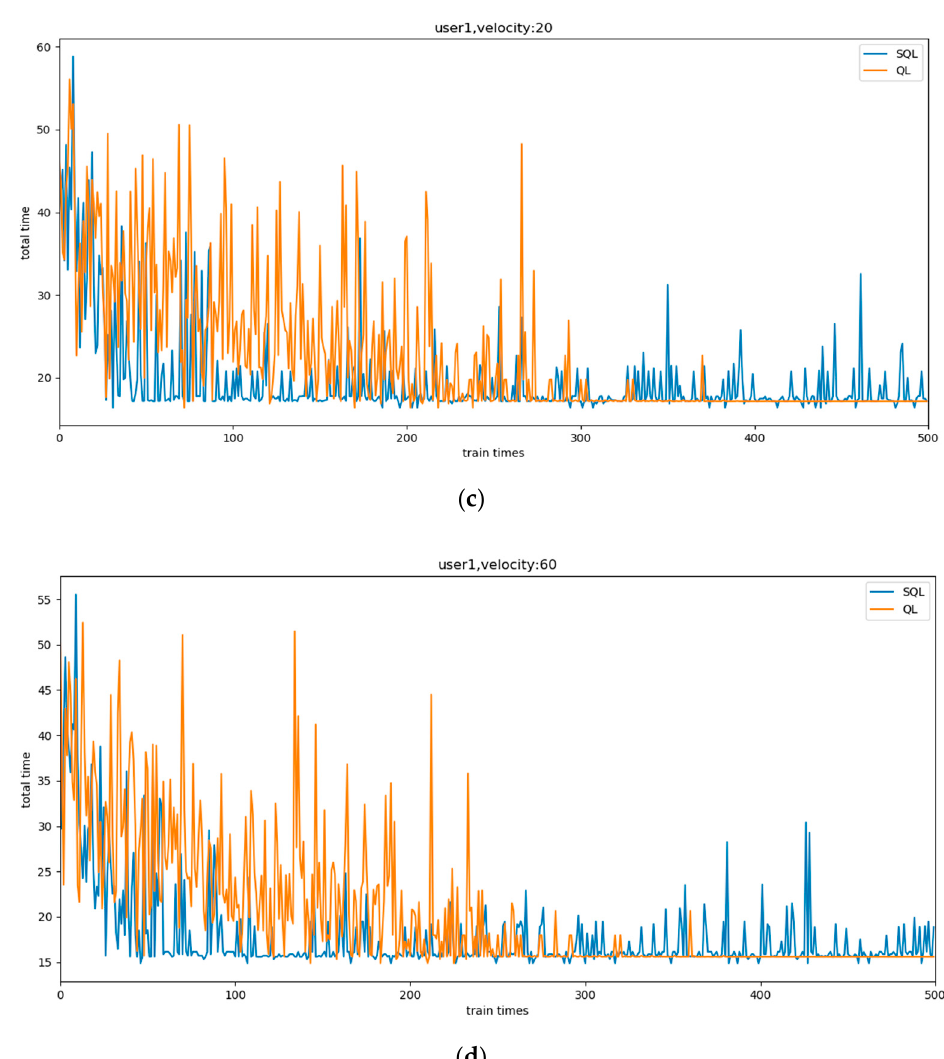
Figure 4. The comparison curve of total sensing time based on heterogeneous user: ( a ) the velocity: 1; ( b ) the velocity: 3; ( c ) the velocity: 20; ( d ) the velocity: 60.